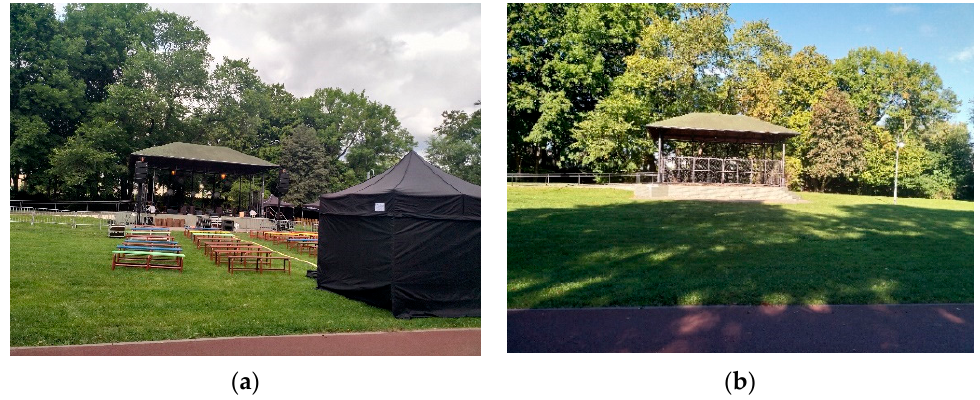
Figure 13. Open-air scene. ( a ) During organized event. Source: author; ( b ) As seen every day in the summer. Source: author. summer. Source: